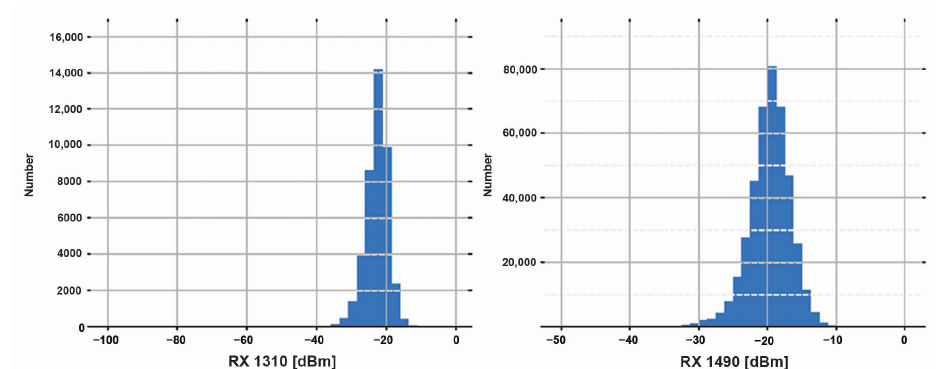
Figure 3. Distribution of GPON signal levels.